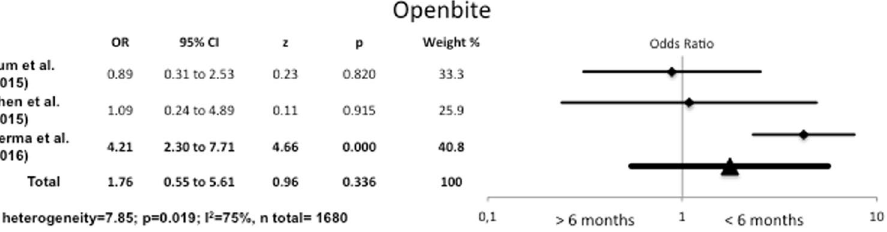
Figure 5. Odds Ratio for openbite, comparing breastfeeding for < 6 months with breastfeeding for > 6